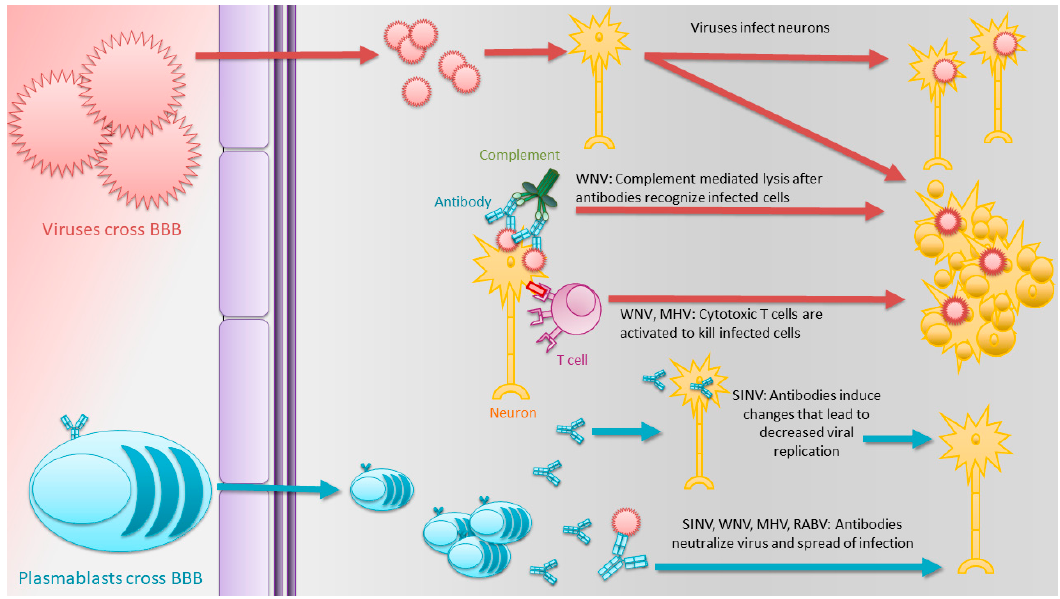
Figure 1. Antibody-mediated viral clearance from the central nervous system (CNS). Viruses cross the blood–brain barrier (BBB) to infect neurons. Without control, the virus continues to spread and